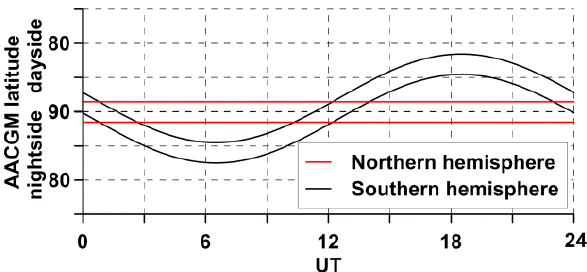
Figure 7. Sectors used for patch analysis.